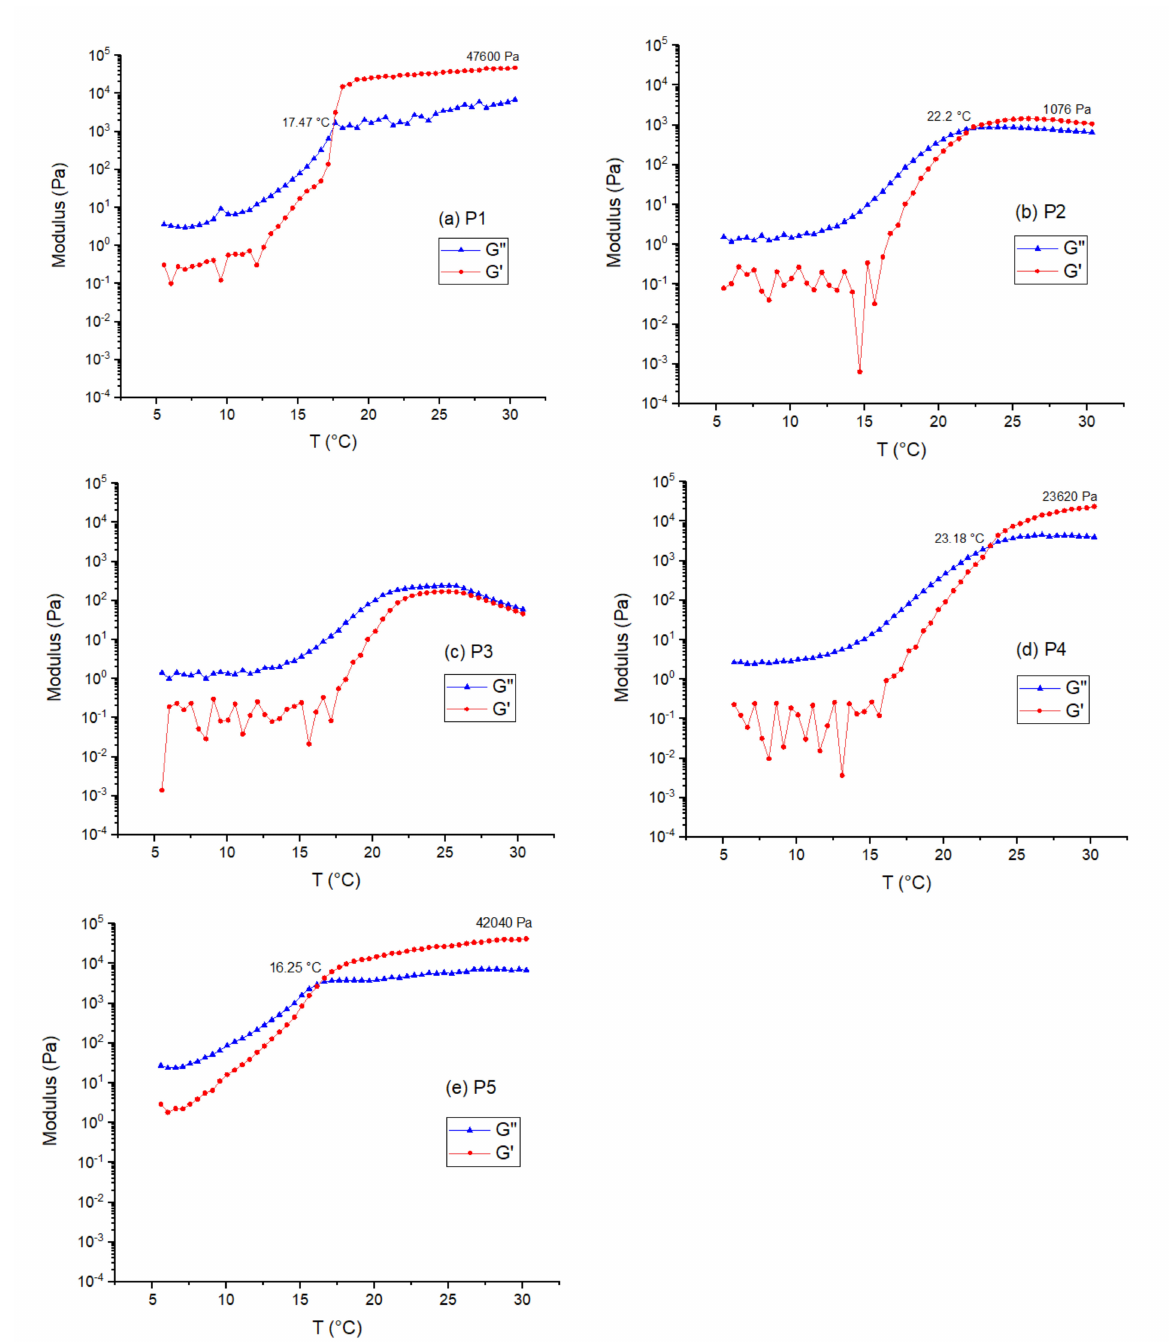
Figure 4. Rheometry graphs of ( a ) PEO 2 -8k-PDEGA (P1); ( b ) PEO 4 -10k-PDEGA (P2); ( c ) PEO 8 -10k-PDEGA (P3); ( d ) PEO 8 - 20k-PDEGA (P4); ( e ) PEO 8 -40k-PDEGA (P5). The red line represents the storage modulus (G (cid:48) ); the blue line represents the loss modulus